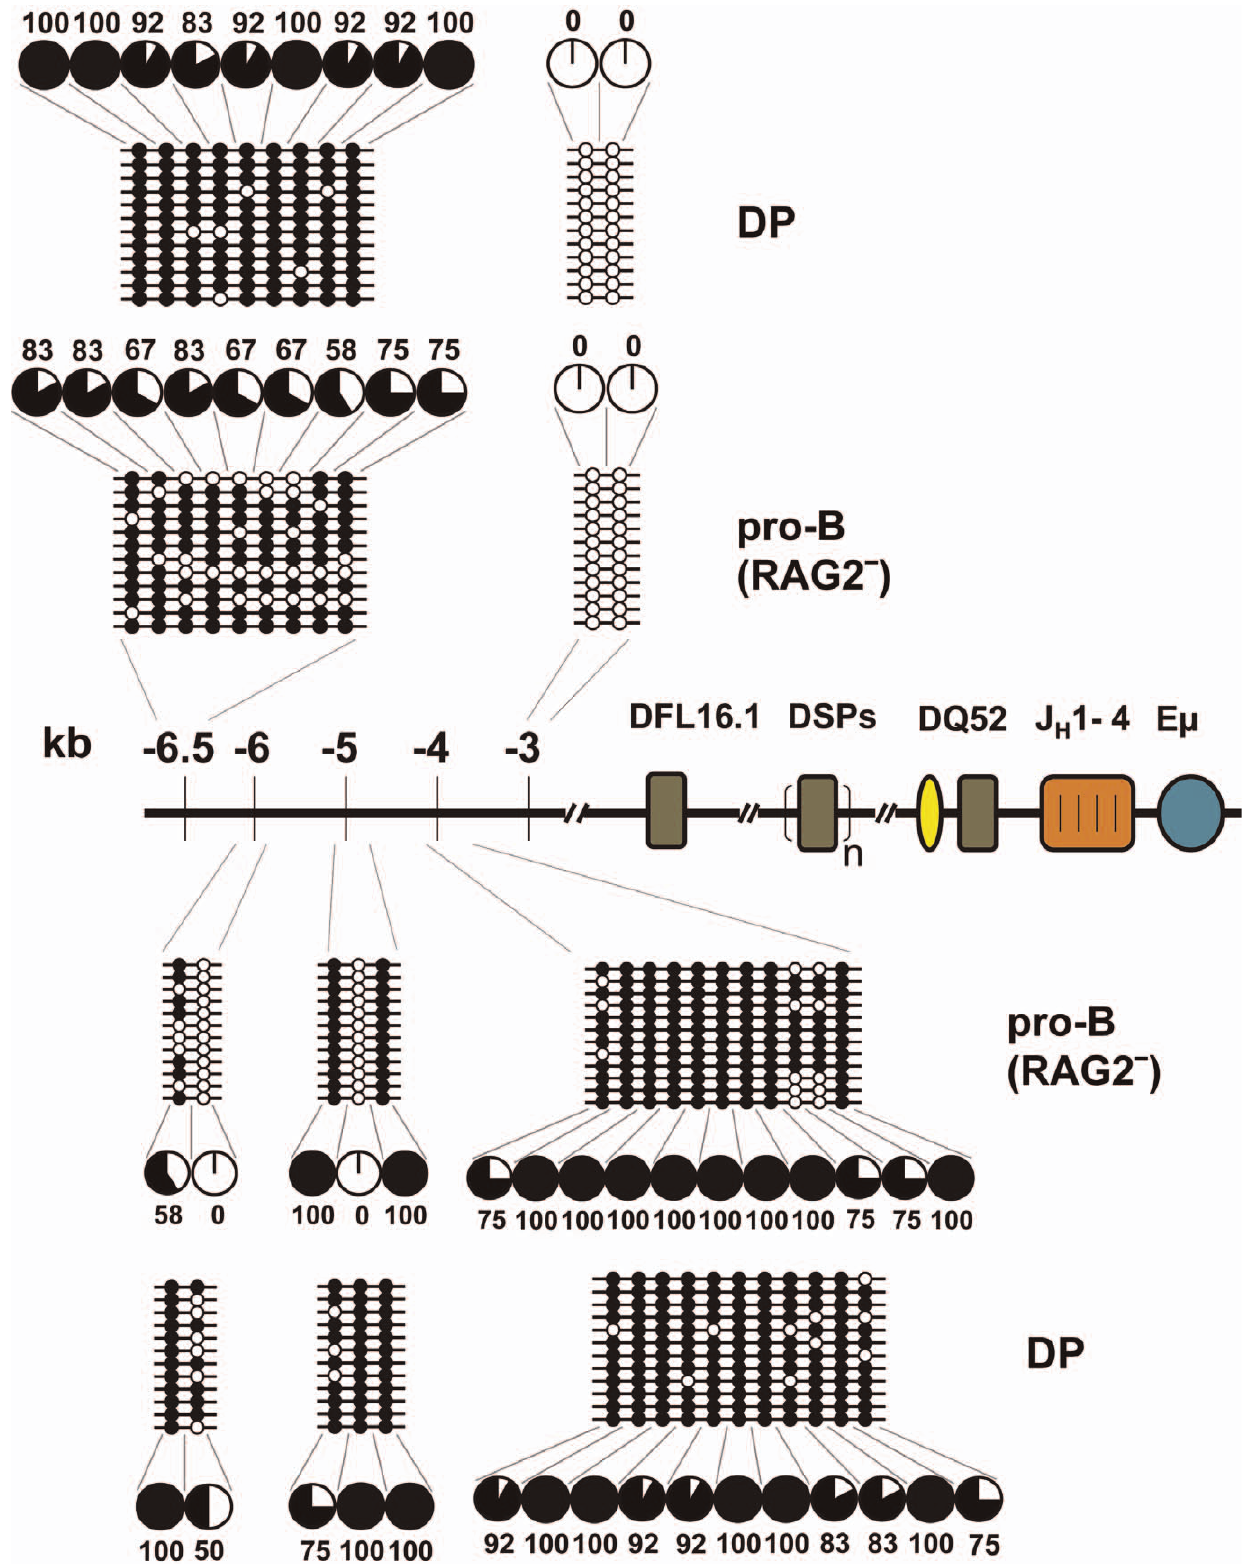
Figure 3. DNA methylation status of DNase 1 hypersensitive sites 5 9 of DFL16.1. Three newly identified DNase 1 hypersensitive sites are located at approximately 6–6.5, 4–4.5, and 0.4–1.3 kb 5 9 of DFL16.1. Genomic DNA from primary RAG-deficient pro-B cells and DP (CD4 + CD8 + ) thymocytes were used in bisulfite mapping experiments to examine CpG methylation. Five amplicons covering regions between 3 kb and 7 kb 5 9 of DFL16.1 were modified, cloned, and sequenced. The distribution of CpG dinucleotides within each amplicon are noted in Figure S3. Filled and open circles represent methylated and unmethylated residues, respectively. Pie charts summarize the percentage of methylated alleles at each position. doi:10.1371/journal.pbio.1001475.g003 PLOS Biology |